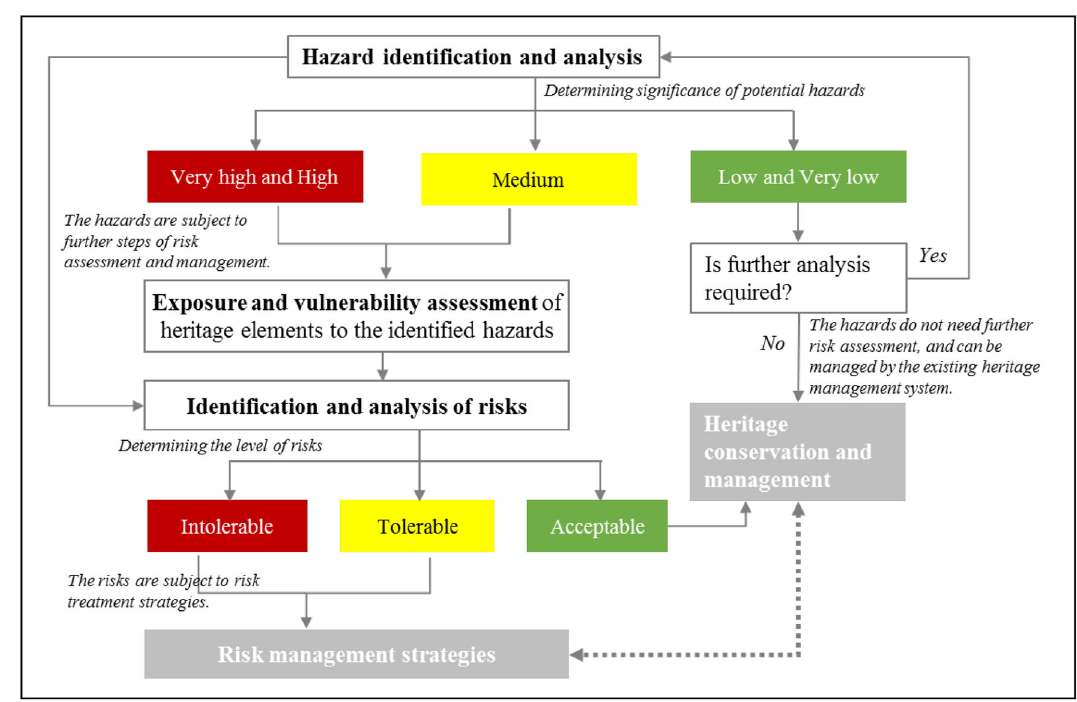
Fig. 7 Natural hazard evaluation and integration into the ongoing risk assessment and management of cultural